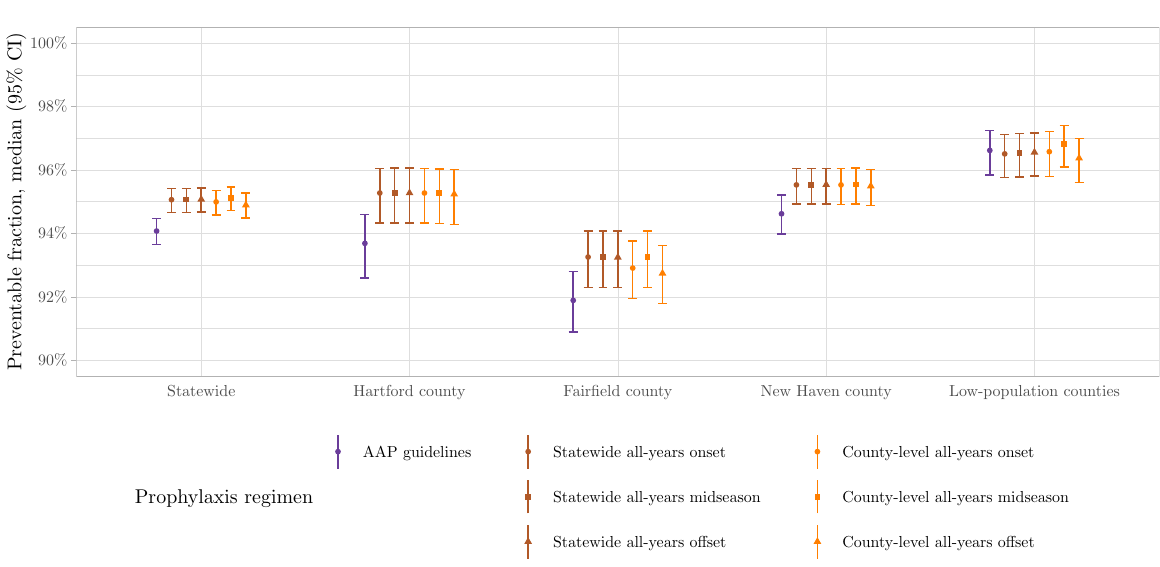
Figure 5. Comparison of six spatially adjusted RSV prophylaxis regimens to the AAP-recommended regimen. Spatially adjusted propxylaxis regimens are either non-inferior (for county-level analysis) or superior (for statewide analysis) to the AAP-recommended regimen. Preventable fraction: the fraction of all RSV-associated hospitalizations occurring while the prophylaxis regimen provides protection Figure created using